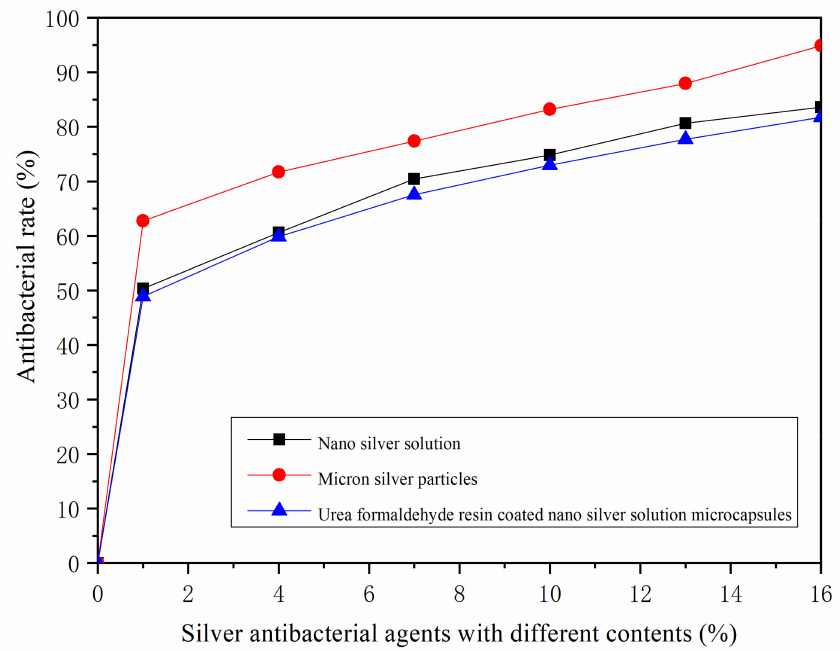
Figure 9. Antibacterial rate of the coating added with micron silver particles, nano-silver solution, and urea formaldehyde resin-coated nano-silver solution microcapsules. The effective antibacterial component of silver antibacterial agents is metal silver, which was added into the water-based coating to form an antibacterial layer. Due to the trace metal silver released by the antibacterial agent, the protein in the Staphylococcus